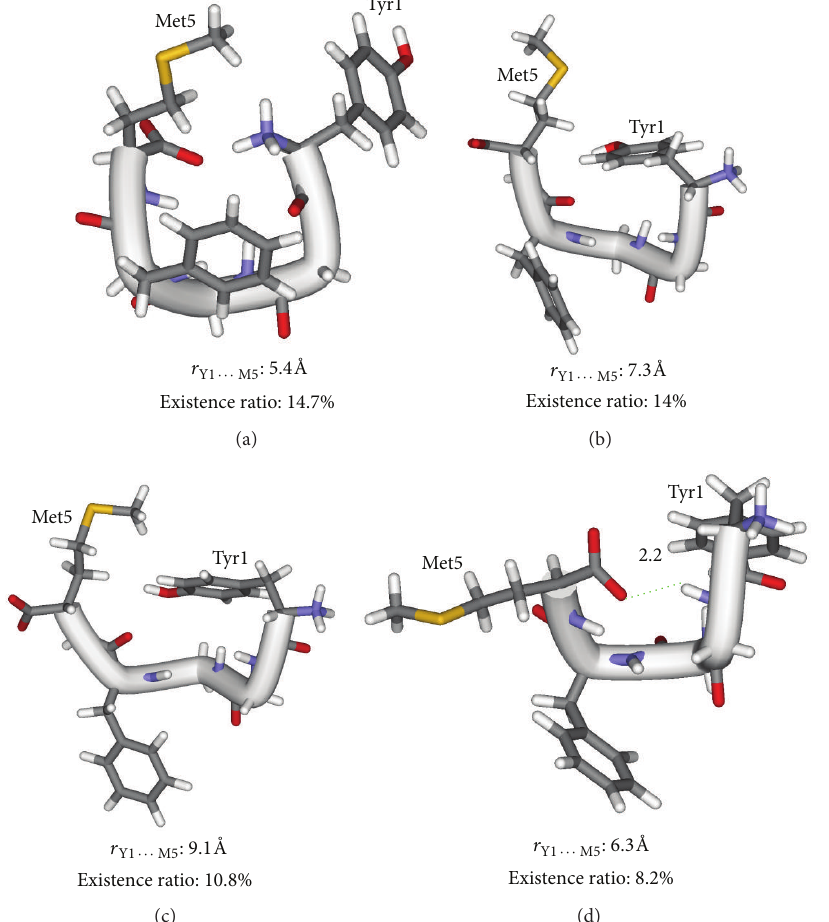
Figure 4: Representative structures of Met-enkephalin obtained by the SAAP-MC simulation at 300 K in water (trajectory 1). The obtained 10,000 structures were analyzed by a structural clustering algorithm using the 𝑘 -means method based on the main-chain RMSD. A distance of the hydrogen bond is given in a unit of